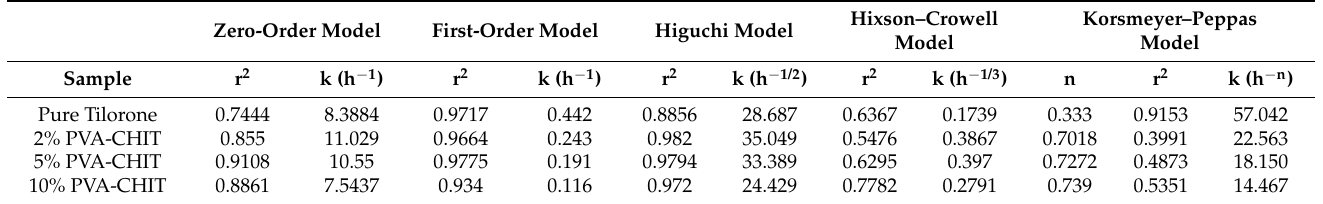
Table 2. Interpretation of the release experiments using different kinetic models in the presence of lysozymes.